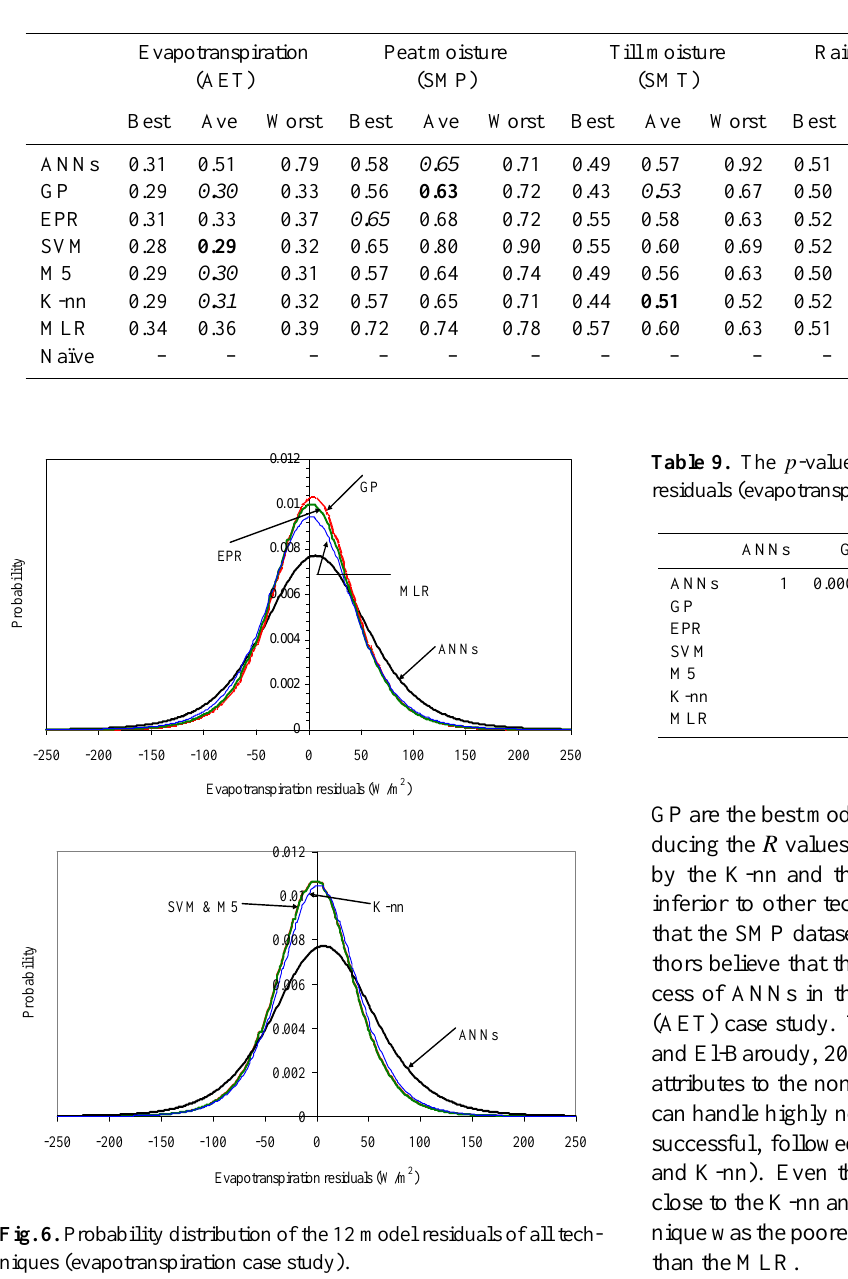
Table 8. IPE testing results of all models applied to all datasets.